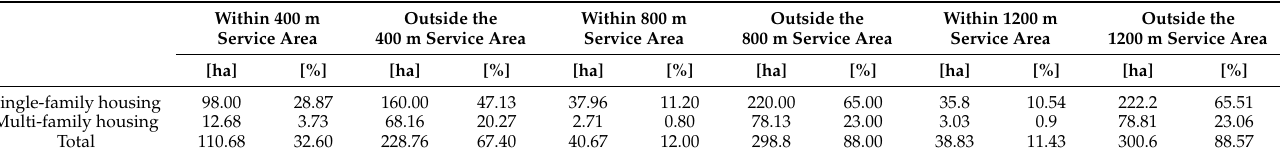
Table 4. Residential sites located within the service areas of PGS and outside: current